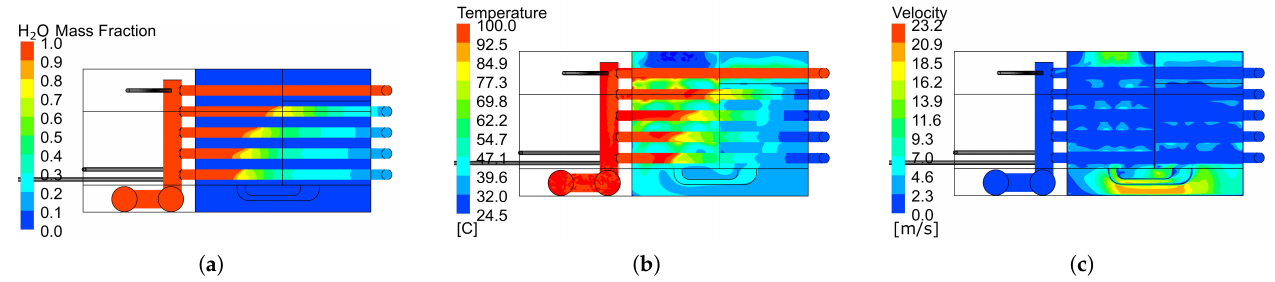
Figure 7. H1 cross-section: ( a ) H 2 O mass fraction; ( b ) temperature distribution; ( c ) velocity magnitude. Figure 8a,b present steam mass fraction and temperature distributions, respectively